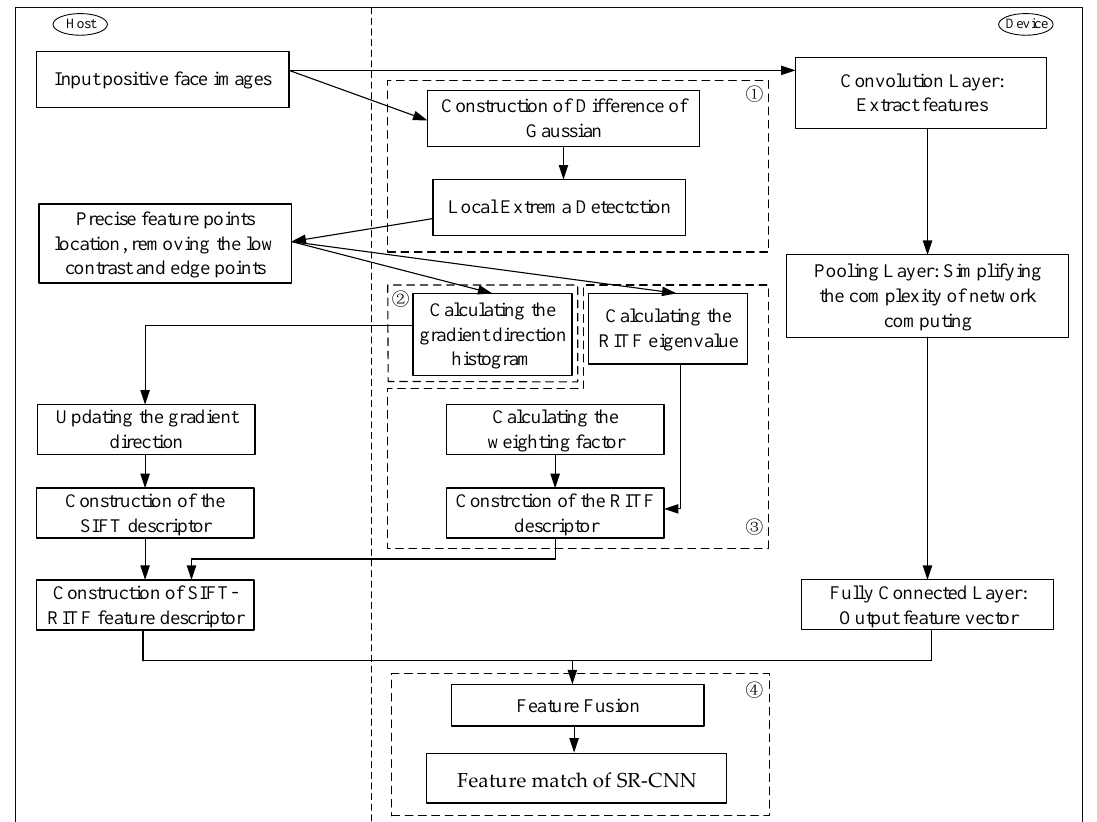
Figure 6. Framework of parallel computing in the SR-CNN